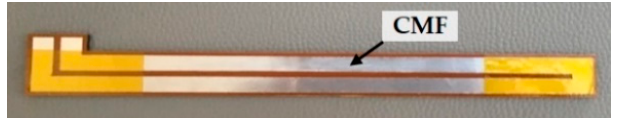
Figure 11. Specimens used in the measurement of mechanical properties: ( a ) specimen in the test; ( b ) specimen after the test; ( c ) front of specimen; ( d ) back of specimen.